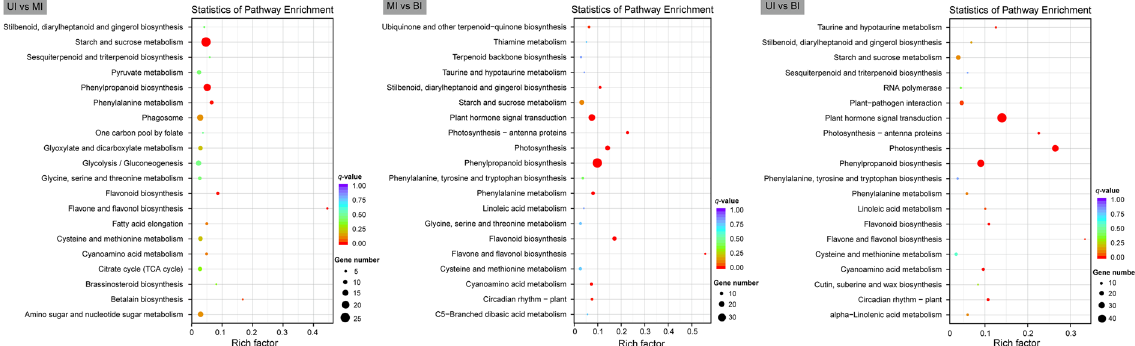
Figure 5. Enrichment analysis of KEGG pathways for differentially expressed genes. Significantly enriched KEGG pathways were plotted for DEGs among the three segments of internode. UI, upper internode, MI, middle internode, BI, basal internode.